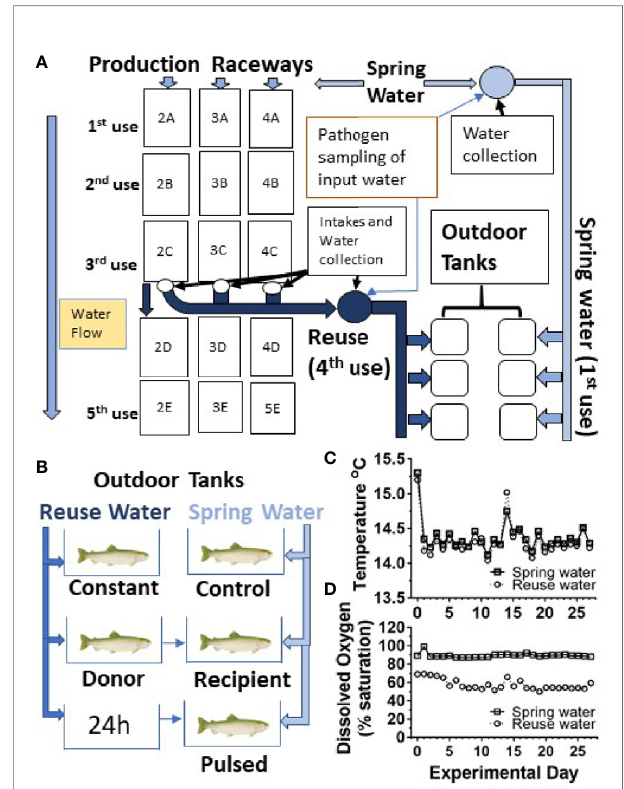
FIGURE 1 | Experimental design and water quality measurements. (A) Schematic diagram of water fl ow to production raceway series 2, 3 and 4 and the collection of fi rst and fourth use water for outdoor tank system. The reuse water has passed through three raceways (3 uses) and was equally comingled prior to supplying the outdoor experimental tank systems, constituting the reuse (4 th use) treatment. Water exposure groups (B) , temperature (C) and oxygen pro fi les (D) . Spring water (squares) Reuse water